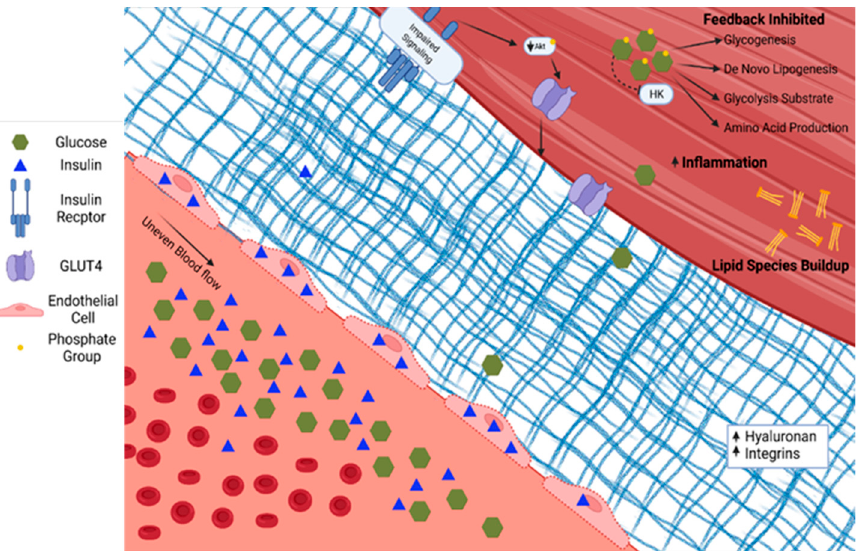
Figure 2. Type 2 diabetes is characterized by increased glucose and insulin in circulation. Insulin accumulates in endothelial cells. The extracellular matrix becomes fibrotic with increased hyaluronan and integrins. Serine/threonine phosphorylation on the insulin receptor and insulin response substrates leads to blunted insulin signaling through PI3K/Akt. The glucose diffusion gradient is limited by elevated intracellular glucose concentrations and allosteric down-regulation of intracellular glucose metabolism. Hexokinase (HK). Phosphokinase B (Akt). Glucose and insulin access to the skeletal muscle are also limited by T2D-mediated changes to the perivascular and skeletal muscle extracellular matrix. The extracellular ma- trix plays a key role in capillary angiogenesis and regression [49] and insulin signaling